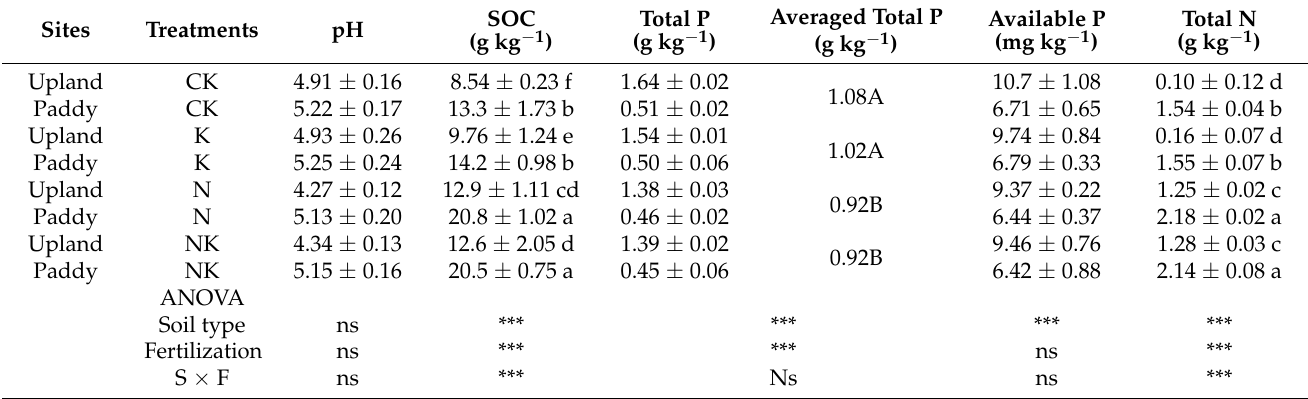
Table 3. Effect of long-term fertilization on the soil pH, SOC, total P, available P and the total N concentrations in upland and paddy